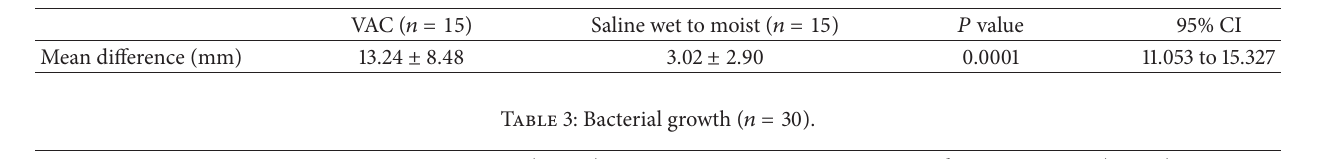
Table 2: Mean wound size difference between VAC and saline wet to moist on day 8.